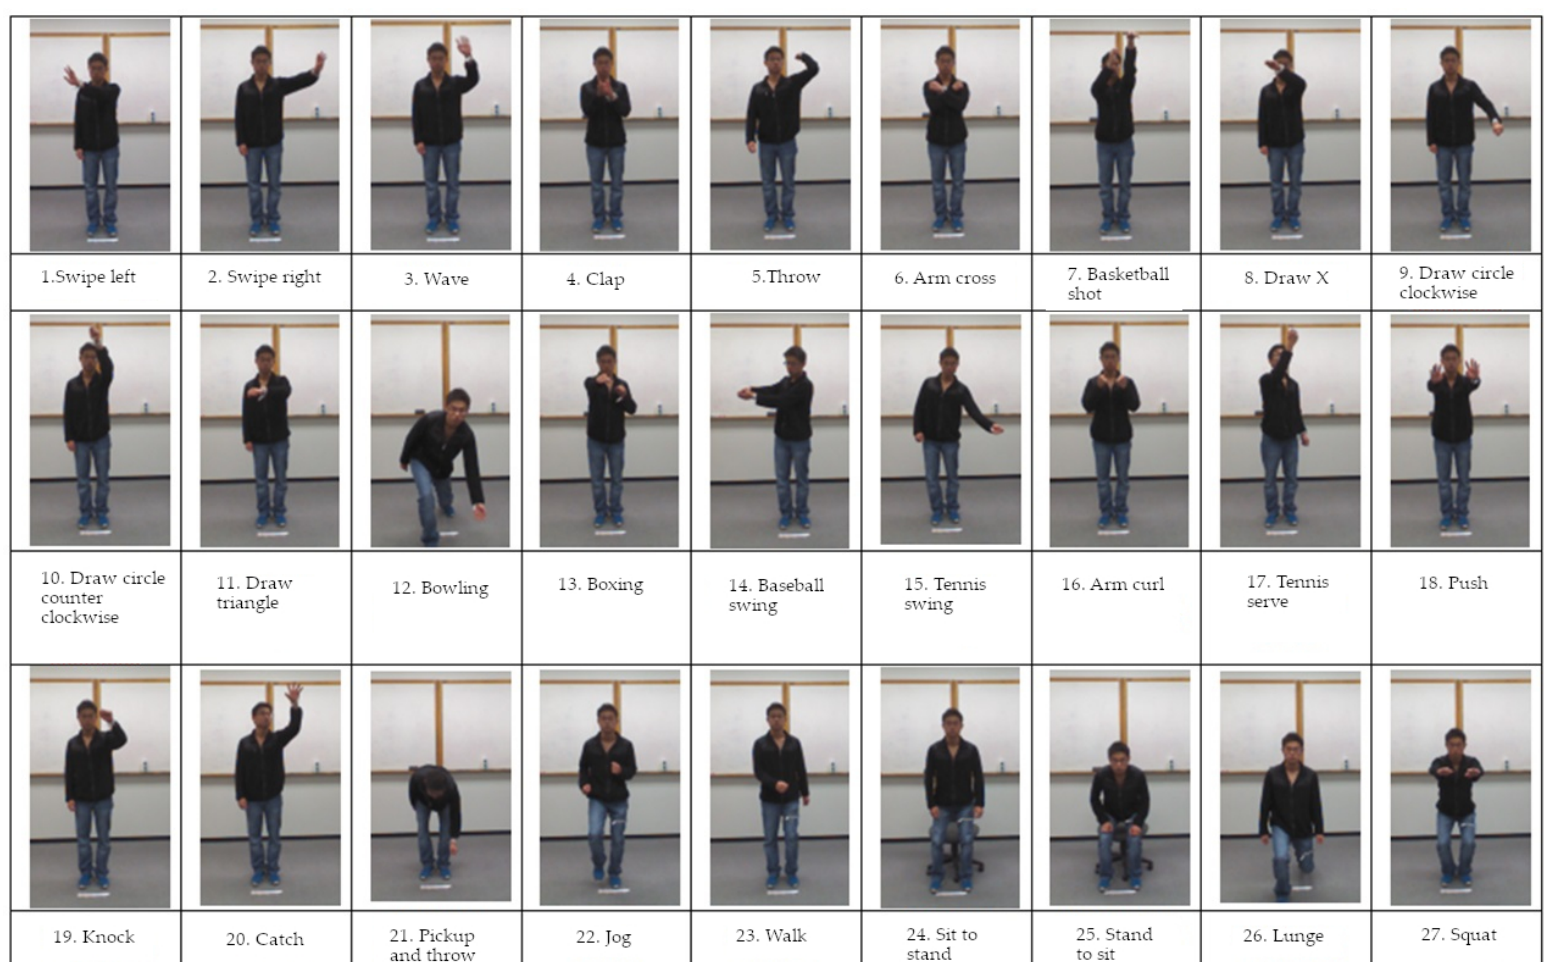
Figure 6. Activities in the University of Texas at Dallas Multimodal Human Action Dataset